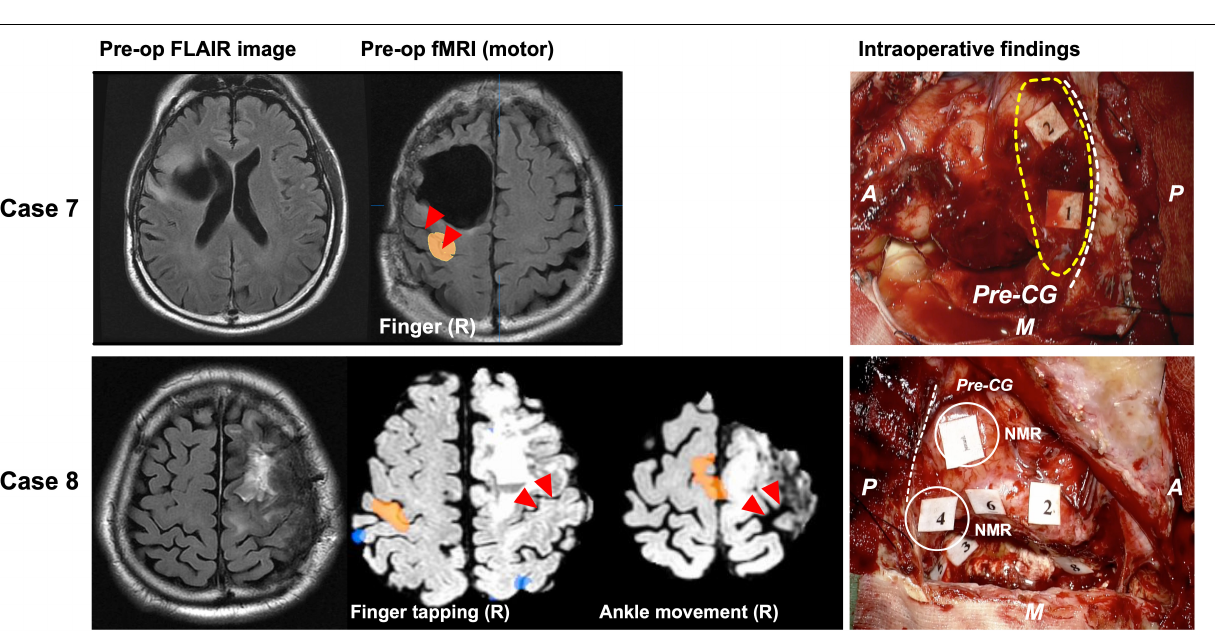
FIGURE 5 | Patients whose motor functioning shifted, but the destination of the shift is unknown. The left column shows the preoperative FLAIR image. In case 8 (lower column), the functional MRI investigation for the movement task of the right finger and the foot revealed the BOLD in the precentral and postcentral gyri of the right cerebral hemisphere (middle two columns). During surgery, involuntary movement was not observed in the motor area, but negative motor response was observed (Right lower column, white circle). The red triangles in the middle column and white broken line in the right column indicate the central sulcus; The yellow broken line in the upper right column indicates motor area recognized as positive motor response in previous surgery; A: anterior; P: posterior; M: medial side; broken white line: central sulcus. Tags indicate intraoperative findings as follows: Case 7: Tags 1 and 2, anarthria; Case 8: Tags 1 and 4, negative motor response (NMR) in cortical level; Tag 2, paraphasia; Tags 3 and 5, NMR in subcortical level; Tags 6 and 8, paraphasia; A: anterior; P: posterior; M: medial